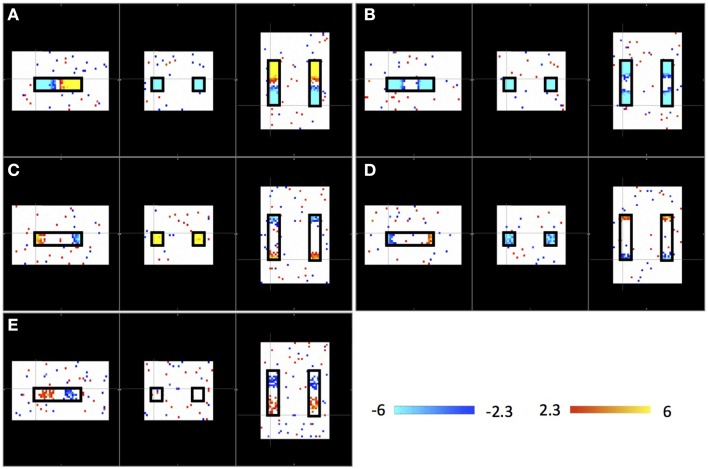
Five ICs (A–E) resulting from ICA on a single “subject.” Each IC pattern is shown in three viewpoints (Sagittal, Coronal, and Axial). The locations of synthetic traveling waves are indicated by the black boxes in all three views. The color bar represents the z-value as result of ICA.